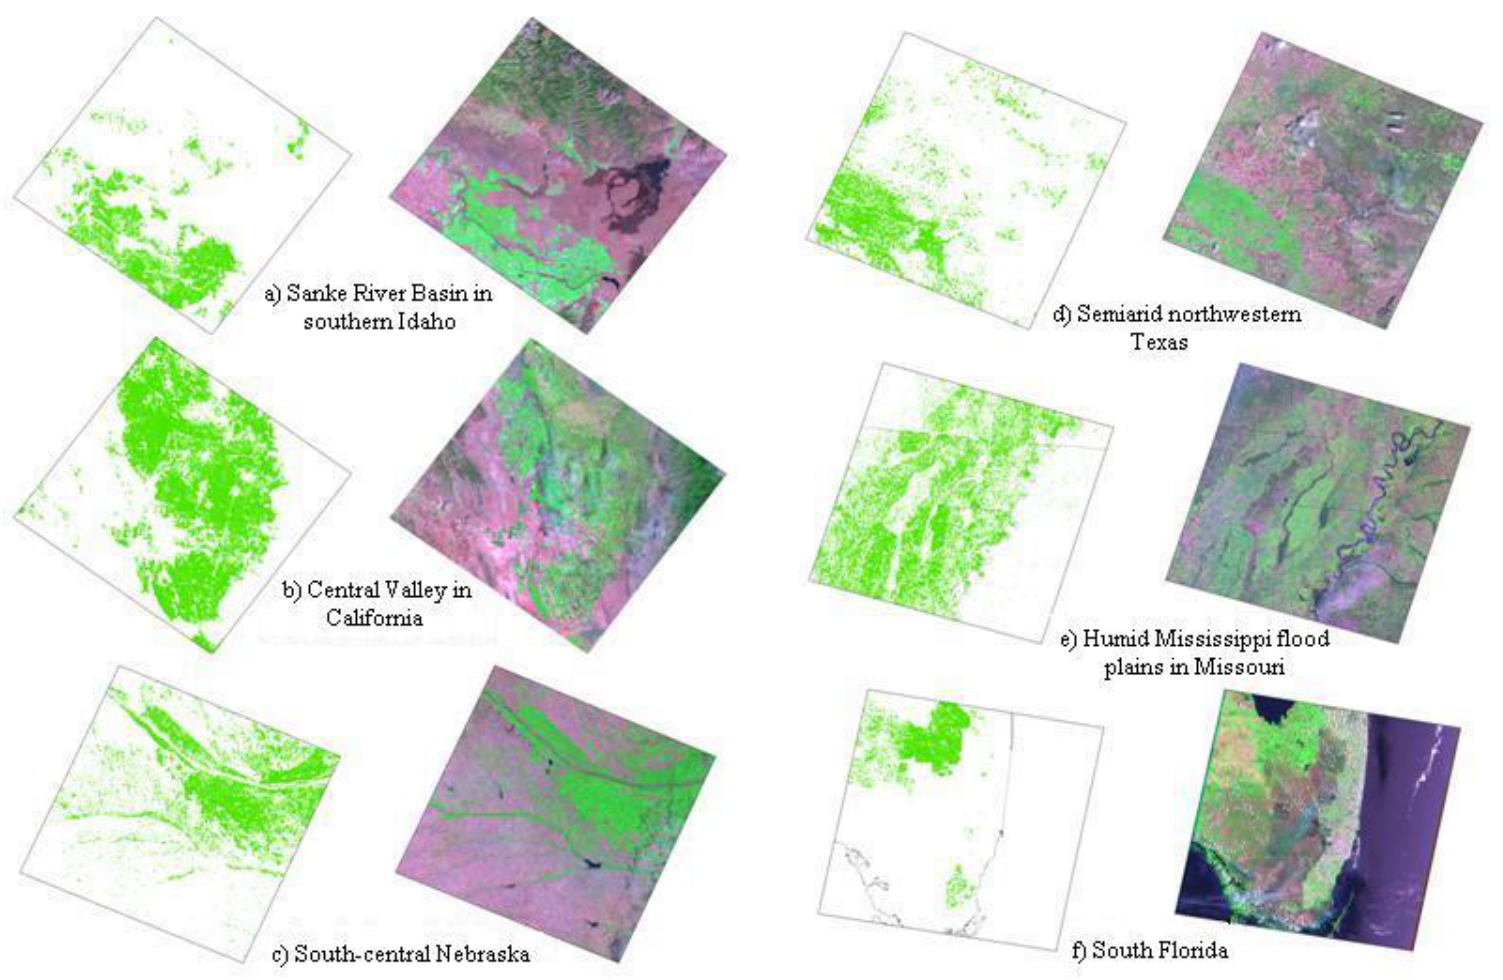
Figure 7. MIrAD-US (first and third column) is qualitatively compared with a snapshot of the cropping system depicted by August 2002 Landsat images (second and fourth) in (a) Snake River Basin in southern Idaho, (b) Central Valley in California, (c) south-central Nebraska, (d) semiarid northwestern Texas, (e) humid Mississippi flood plains in Missouri, and (f) South Florida. Landsat bands 7, 4, and 3 are shown in red, green, and blue